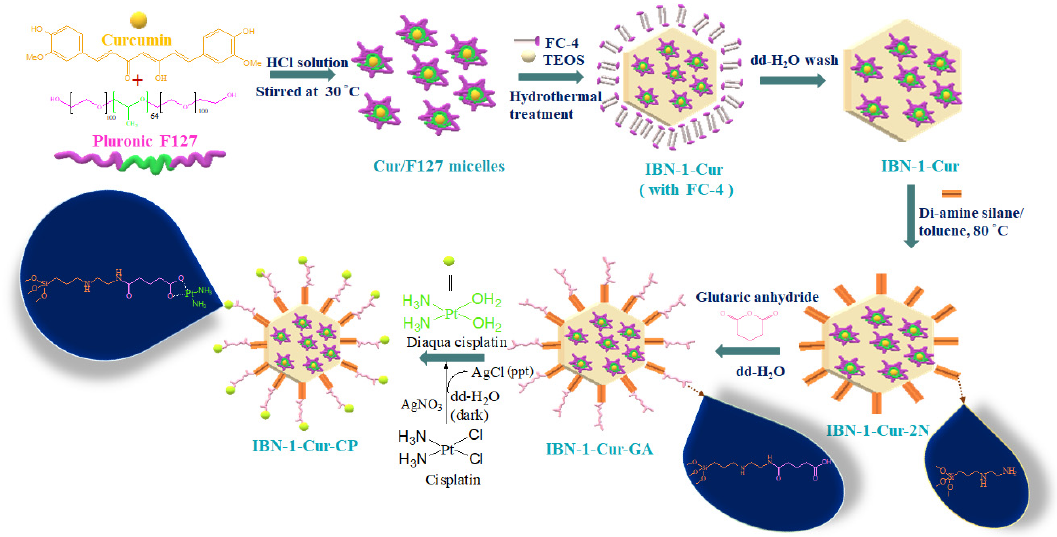
Figure 1. A schematic representation of the synthesis of IBN-1-Cur, subsequent surface modifications, and CP species loading.